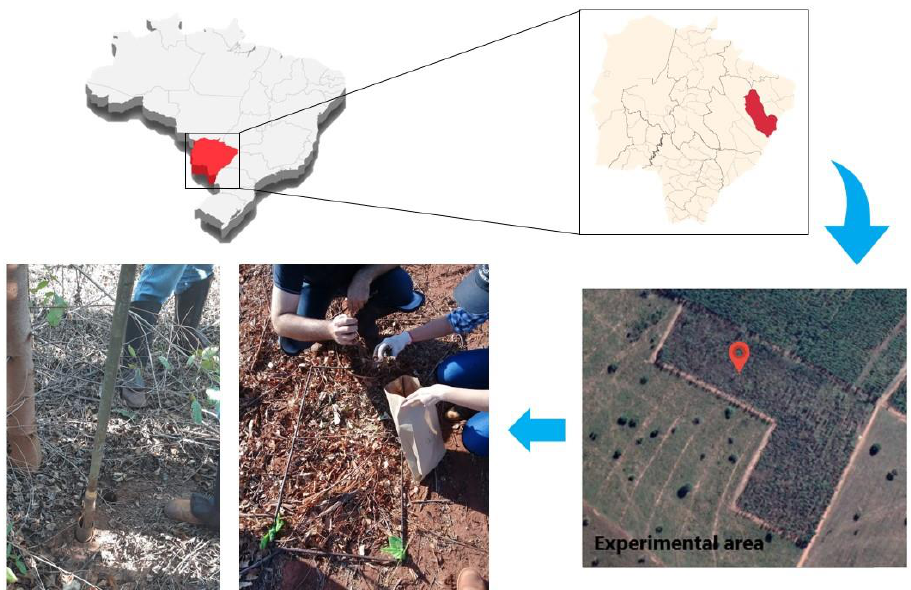
Figure 1. Study area at Três Lagoas, State of Mato Grosso do Sul, Brazil (20° 34′ S, 51 ° 50′ O, and altitude of 305 m). The map was created by using geographic information system (QGIS) software and the Google Earth program. Accessed on 2 August 2021. This image was taken from Google Earth, Google Company (2021). Map data: Google, Maxar Technologies.